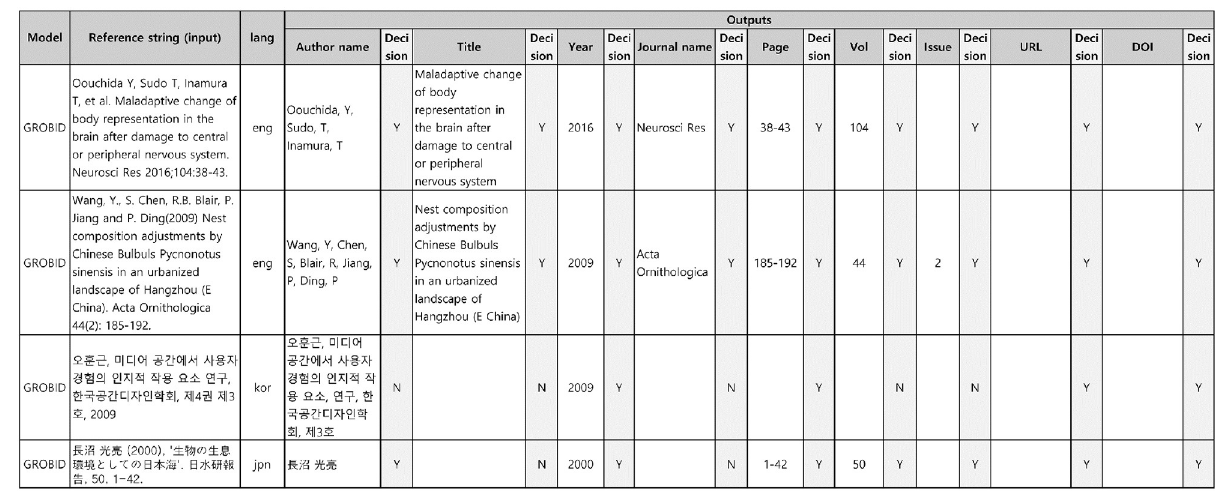
Fig 6. Example of an Excel file containing the predicted metadata field values corresponding to the references newly extracted for comparing the performance of GROBID and the BERT-based model. The first and second columns represent the model name and the input reference, respectively. The third column shows the language type of each reference string. The remainder are the predicted metadata field values with the decision boxes. The annotators manually entered their decisions into the decision boxes.